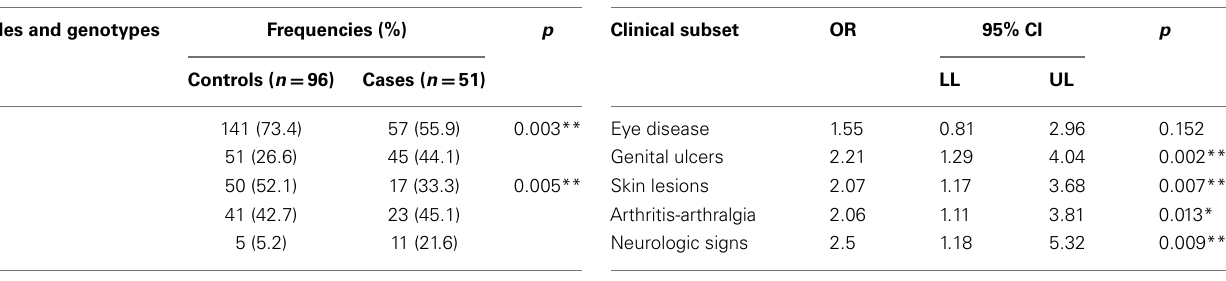
Table 3 |Allelic and genotypic frequencies of rs1800871 variant in BD patients and controls.